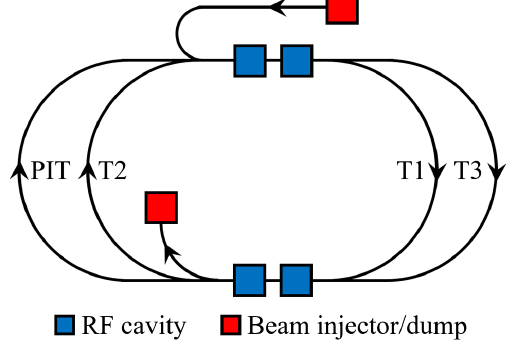
FIG. 1. The MESA facility scheme (ER mode) used in this study.